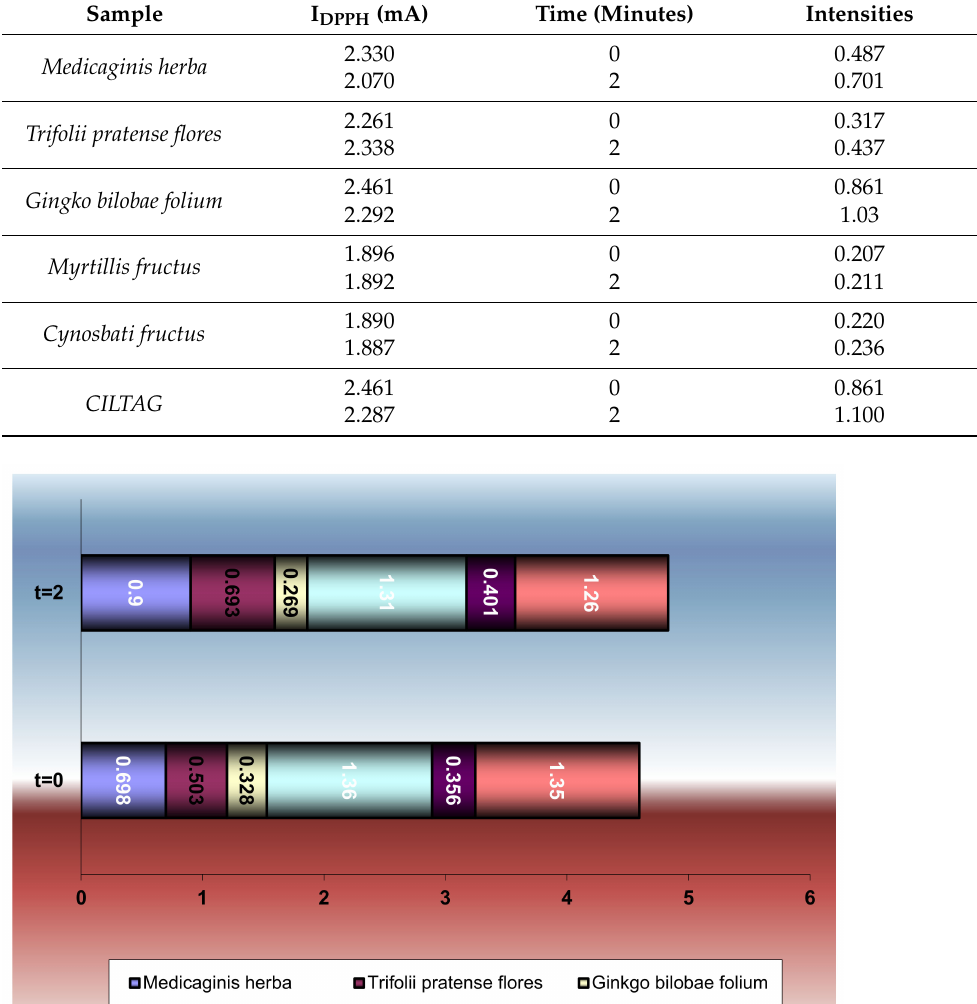
Table 7. The values of the anodic peak current intensities of DPPH in the presence of hydroalcoholic solutions of Medicaginis herba, Trifolii pratensae flores, Ginkgo bilobae folium, Myrtilli fructus, and Cynosbati fructus and CILTAG.